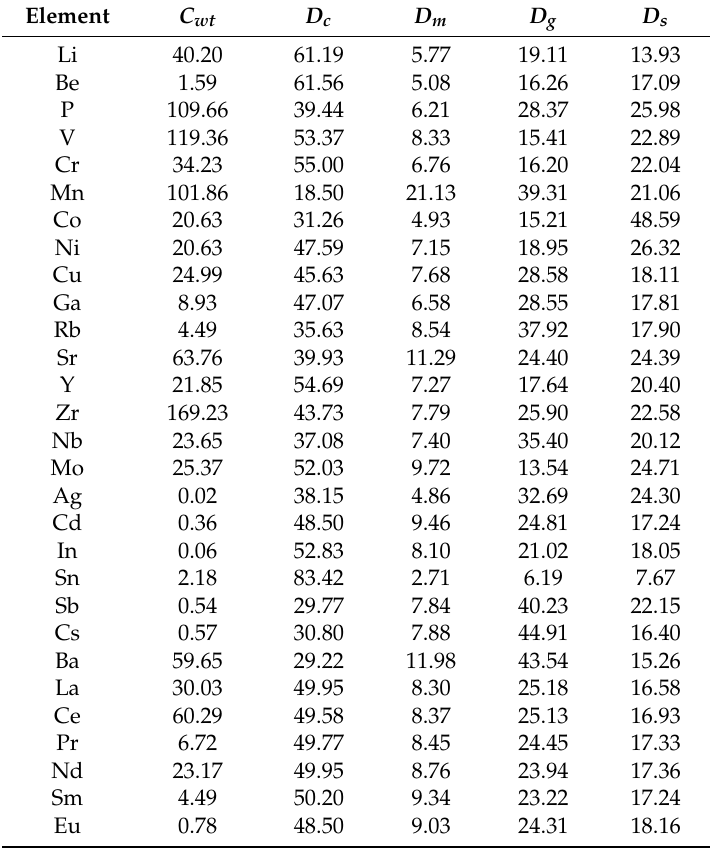
Table 5. The distribution of trace elements among different theoretical products (Unit %).